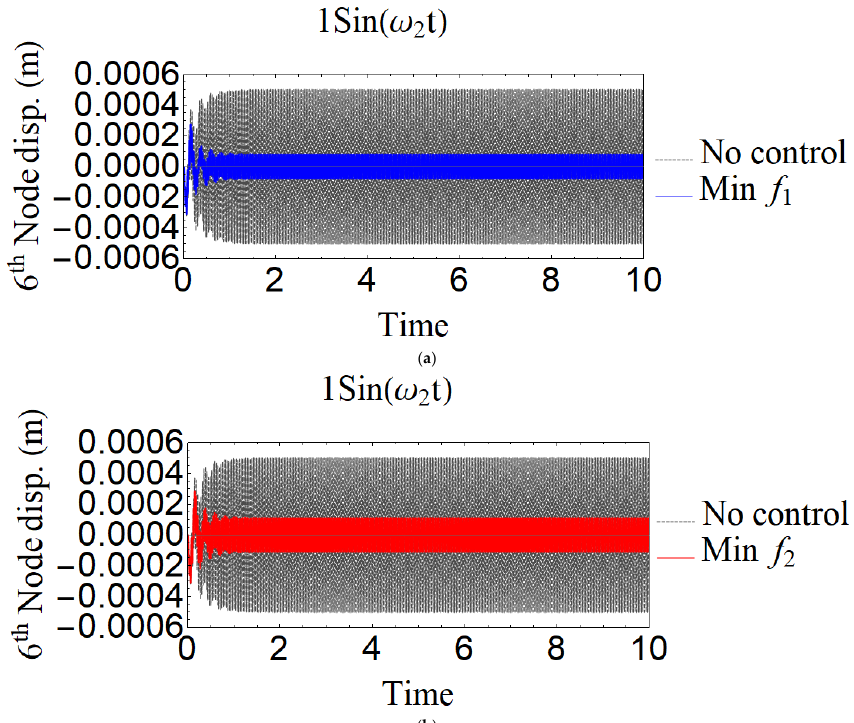
Figure 8. Time history response of the vertical displacement of the 6th node of the cantilever beam under the second mode harmonic base excitation considering ( a ) f 1 and ( b ) f 2 objective functions. Appl. Sci. 2022 , 12 , x FOR PEER REVIEW